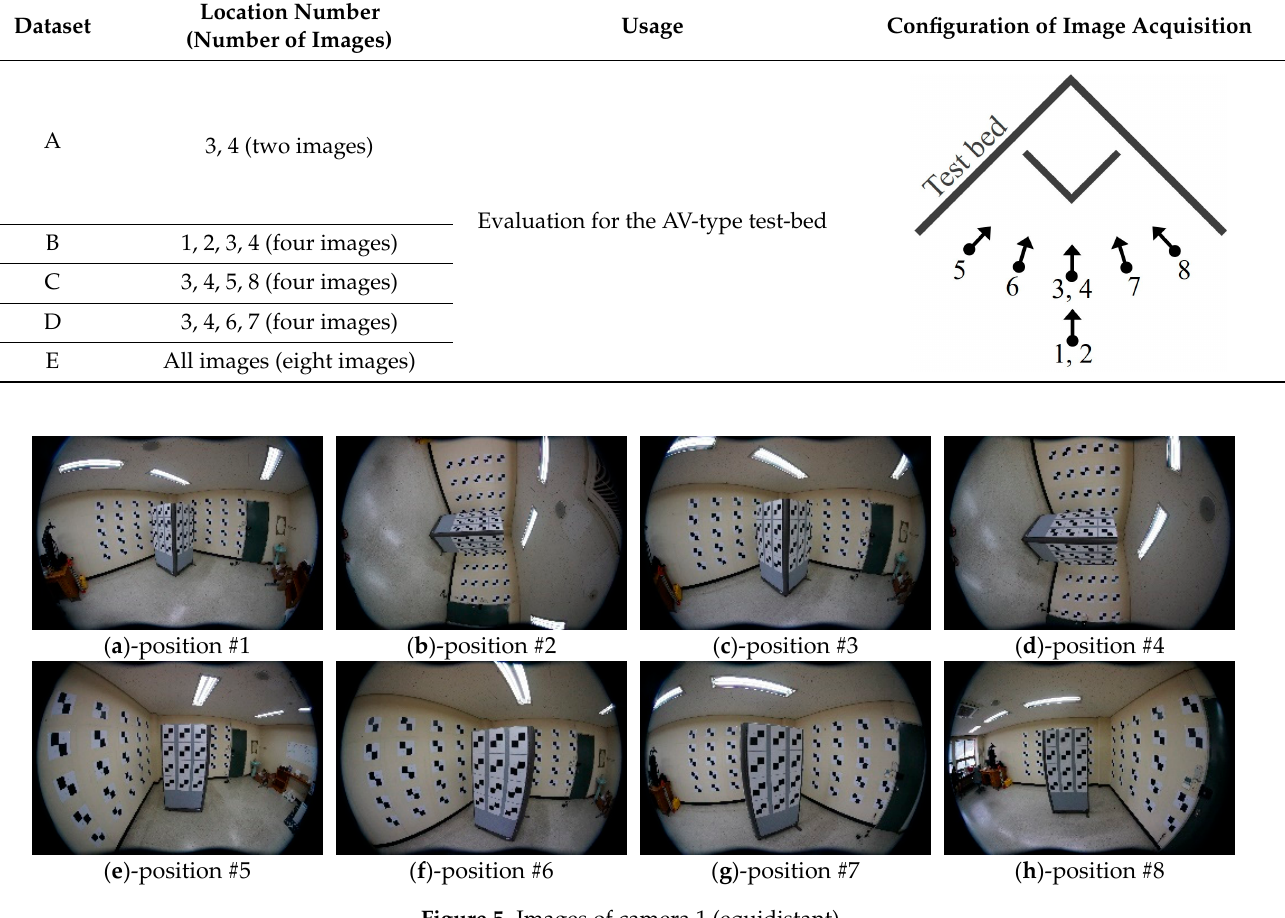
Figure 5. Images of camera 1 (equidistant).